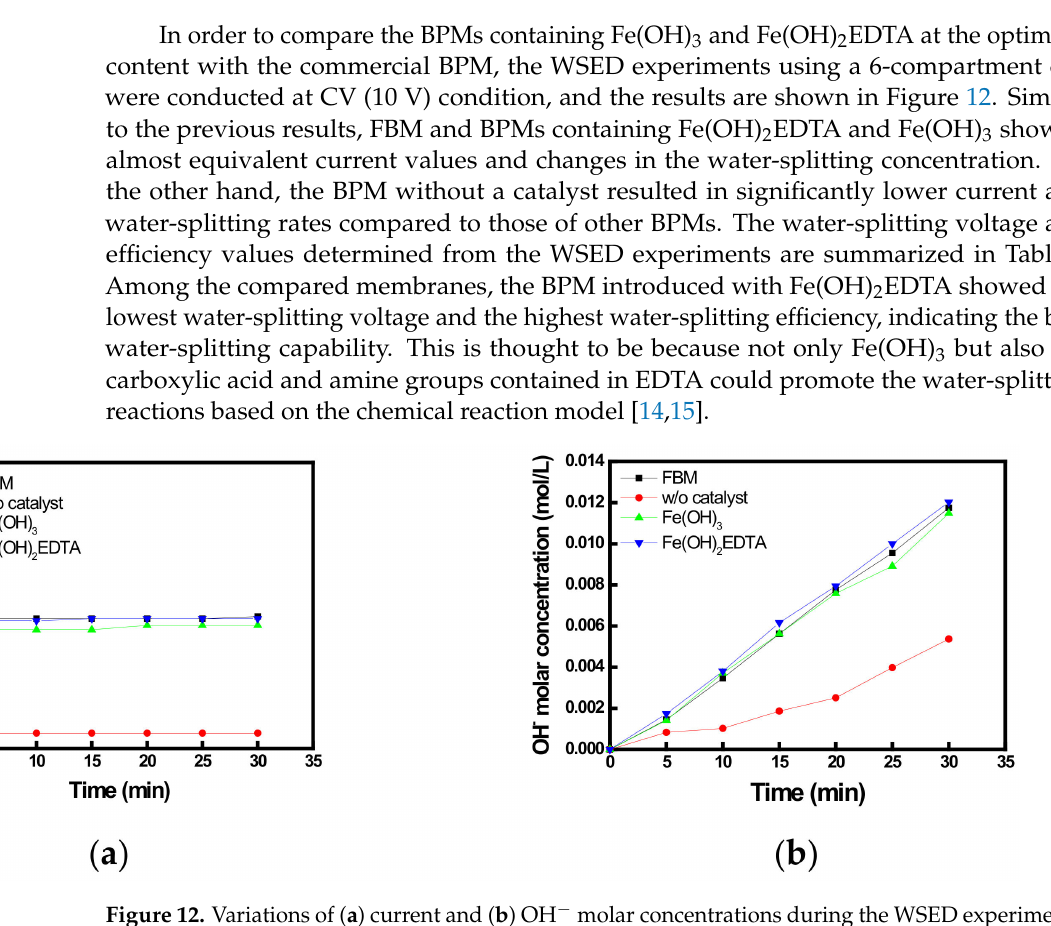
Figure 12. Variations of ( a ) current and ( b ) OH − molar concentrations during the WSED experiments. Table 5. Water-splitting voltage and efficiency values determined from the WSED experiments.